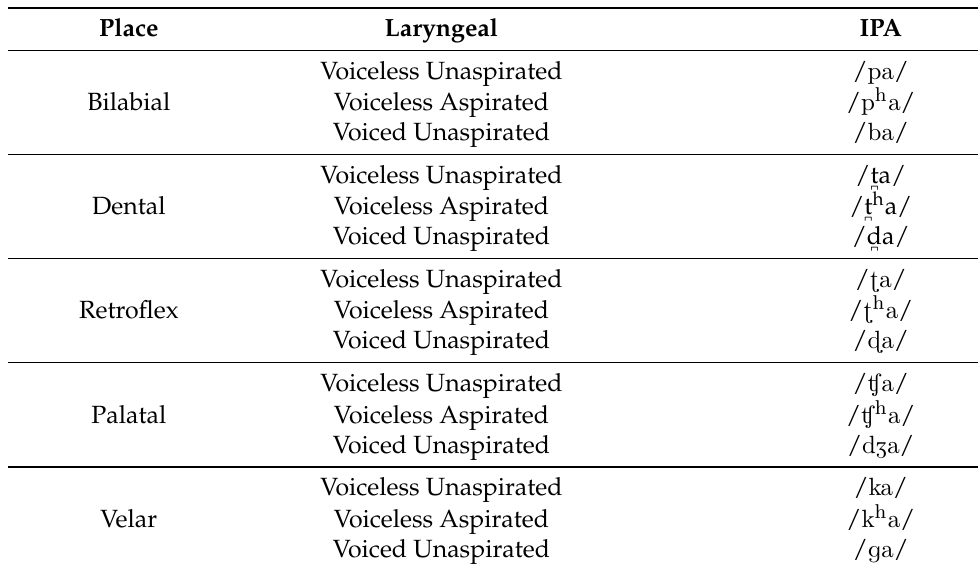
Table A1. List of nonsense words of Shina. The target stops occurred in word-initial position, followed by a neutral vowel /a/.